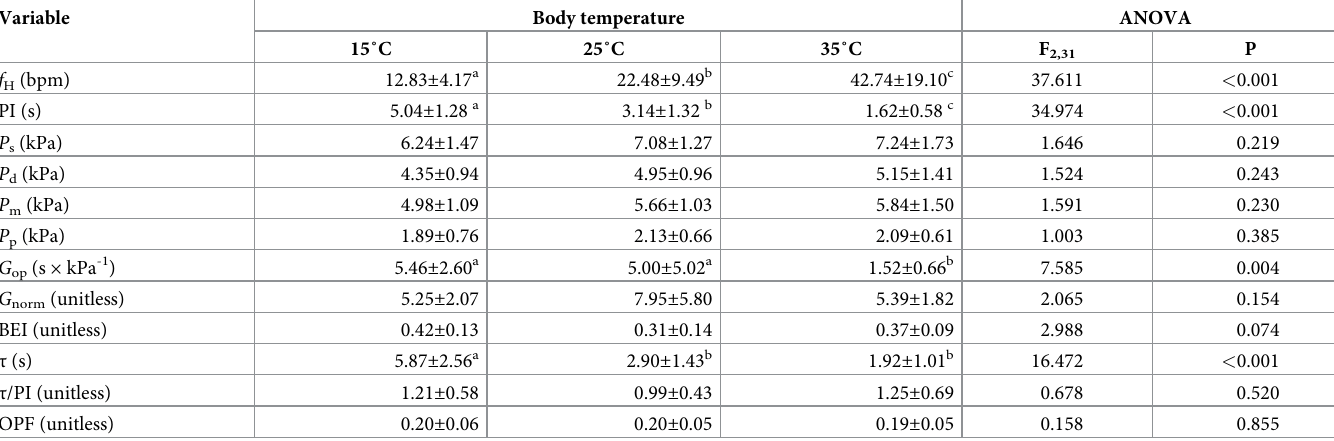
Table 1. Temperature effects on the hemodynamic